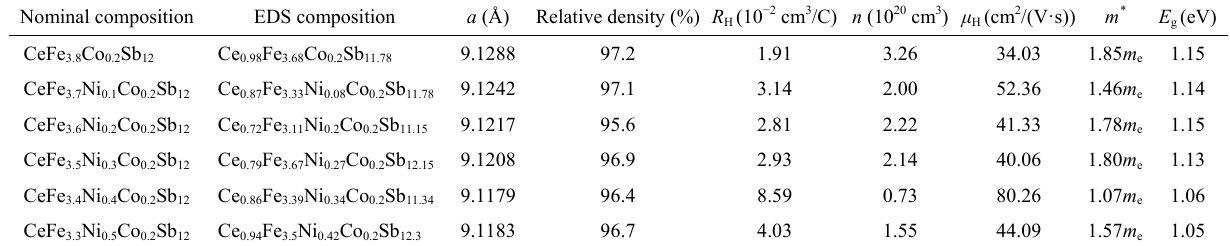
Nominal compositions, EDS compositions, lattice parameter ( a ), relative densities, room-temperature Hall coefficients ( R H ), carrier concentration ( n ), carrier mobility ( μ H ), density-of-states (DOS) effective masses ( m * ), and band gaps ( E g ) of CeFe 3.8– x Ni x Co 0.2 Sb 12 ( x = 0, 0.1, 0.2, 0.3, 0.4, and 0.5) samples